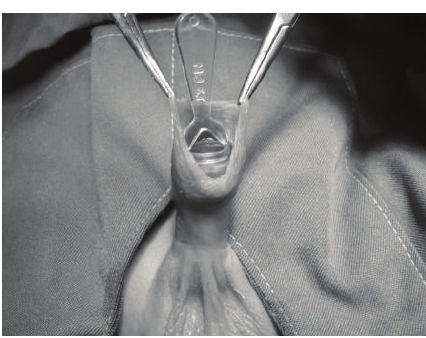
Figure 2: Putting the adequate bell on the glans.